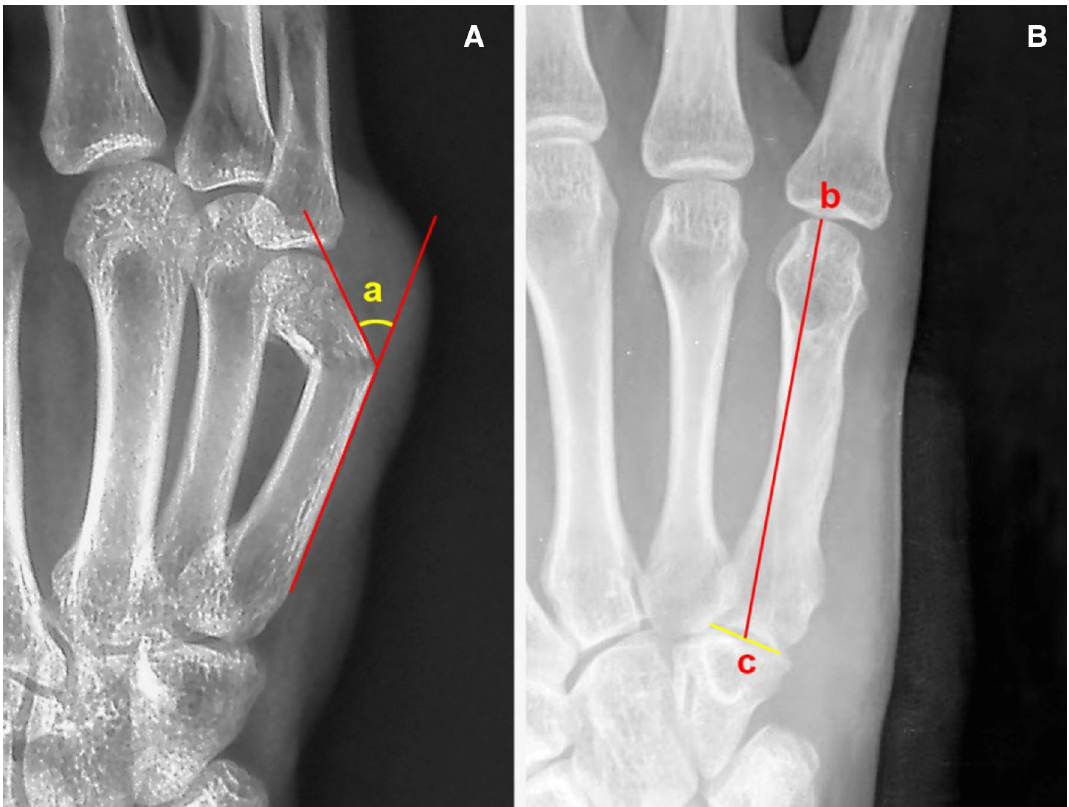
Figure 4. Methods of radiological measurements. Dorsal angulation was defined as an acute angle ( a ) between the line drawn on the dorsal cortex of the fifth metacarpal shaft and the second line on the dorsal cortex of the fifth metacarpal head/neck ( A ). The metacarpal length was defined as the length between the most distal articular surface of the fifth metacarpal head ( b ) and the mid-point (c) of both corners of the fifth metacarpal base ( B ) 16 .